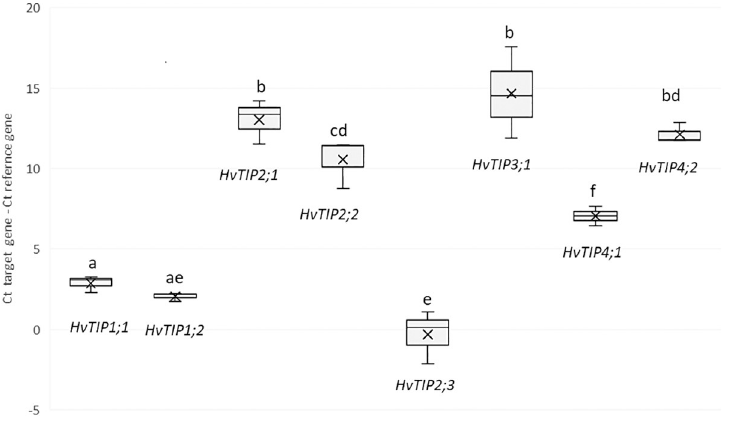
Fig 6. Abundance of transcript level of HvTIPs under control growth (CG) in the leaves of 10-days old barley seedlings calculated from formula: Cycle threshold (Ct) target gene–Ct reference gene ( ADP , ADP-ribozylation factor 1 ). The box-and-whisker plot shows the minimum and maximum (whisker) and median (cross) of a set of data. The statistical analysis was performed using the one-way ANOVA followed by Fisher Least Significant Difference (LSD) test to assess the differences between different expression level of HvTIPs . Statistically significant differences (P < 0.05) are marked by different letters. All samples were analyzed in triplicate.